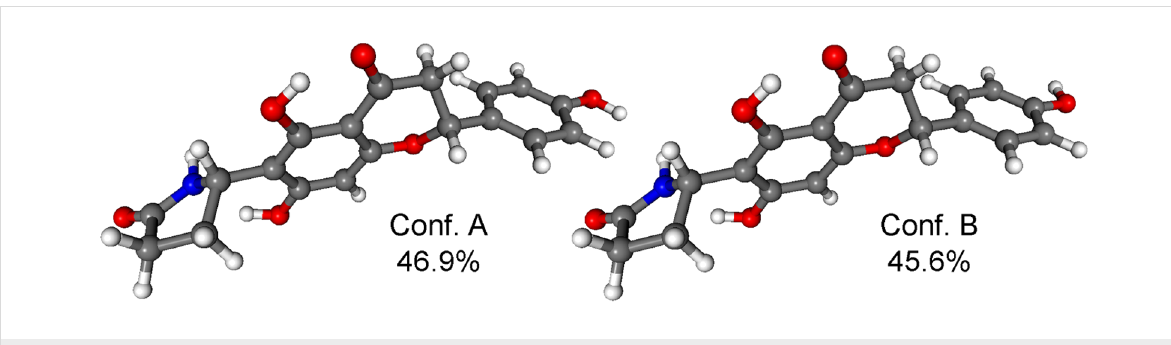
Figure 6: Structure and population of the low-energy CAM-B3LYP/TZVP PCM/MeCN conformers (>2%) of (2 R ,5’’ S )- 2a .